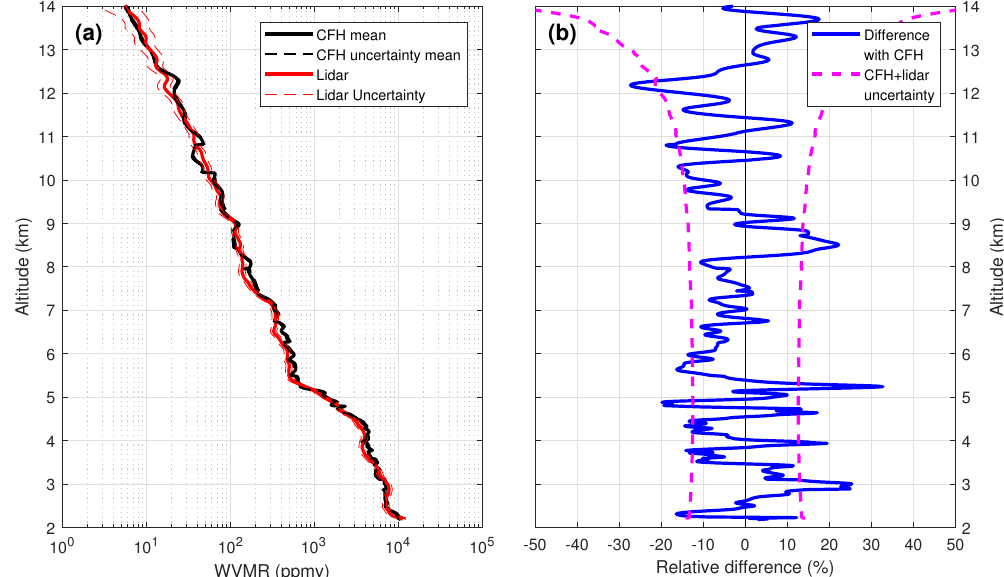
Figure 5. Comparison of the lidar and CFH water vapor mixing ratio during MORGANE in the troposphere between 2.2 km and 14 km. On the left ( a ): superimposition of the mean CFH water vapor profile (thick solid black line) with the lidar profile (solid red line), i.e., the mean profile of the 40-min sessions. The red dotted line represents the ± 1 σ lidar total uncertainty and the black dotted line represents the CFH uncertainty. On the right ( b ): mean relative difference (in %) between the lidar and CFH profiles. CFH data are taken as reference. The sum of CFH and lidar uncertainties is indicated with the magenta dotted